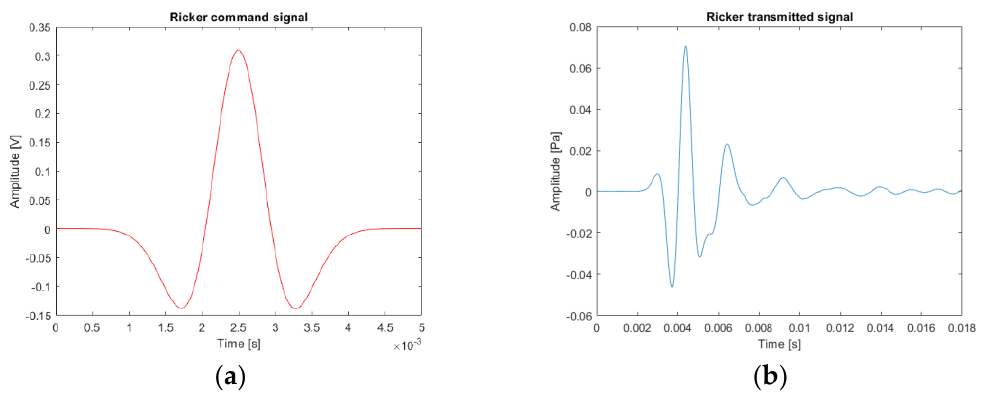
Figure 6. Transfer function of the loudspeaker estimated by emitting a white noise: ( a ) modulus; ( b ) phase.